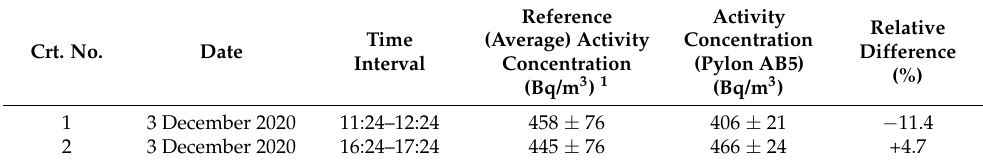
Table 3. The results obtained in the calibration of the Pylon AB5 radon monitor.